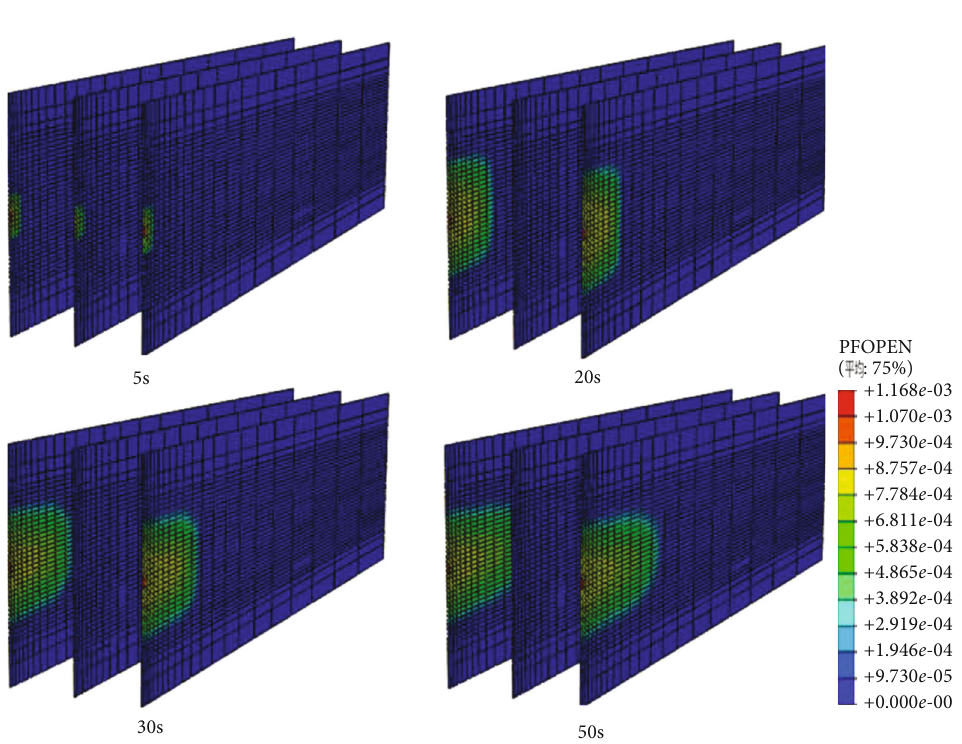
Figure 5: Fracture geometry after pumping for 5s, 20 s, 30s, and 50 s in case